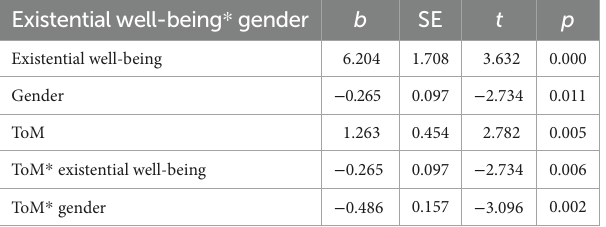
TABLE 4 Moderating role of existential well-being and gender on the relationship between ToM and prosocial behaviour. Existential well-being * gender b SE t p Existential